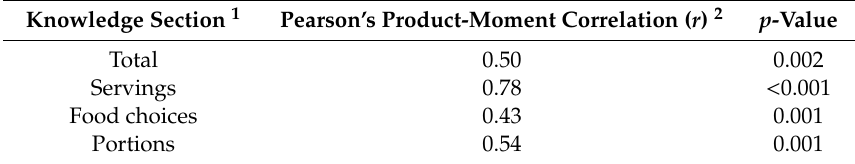
Table 3. Test-retest reliability using Pearson’s product-moment correlation ( n = 35; nutrition students